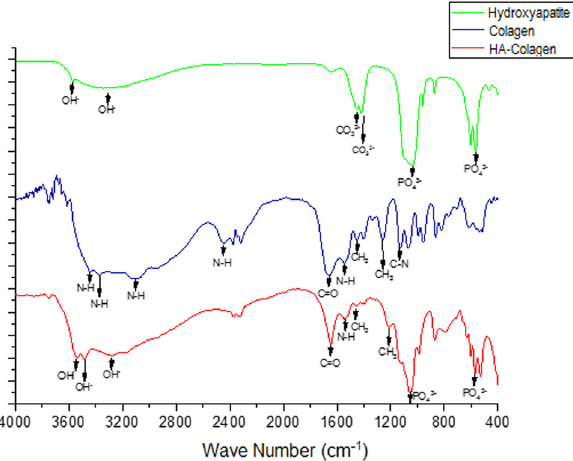
Figure 5: FTIR of HA, collagen, and collagen – HA composite.